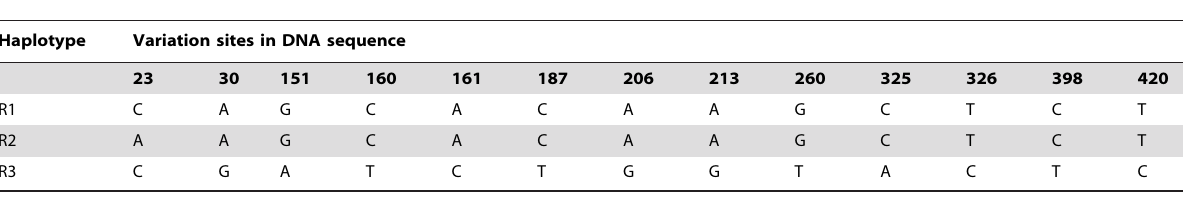
Table 4. Variation sites in DNA sequences of Bactrocera species for mitochondrial 16S rDNA from various localities.